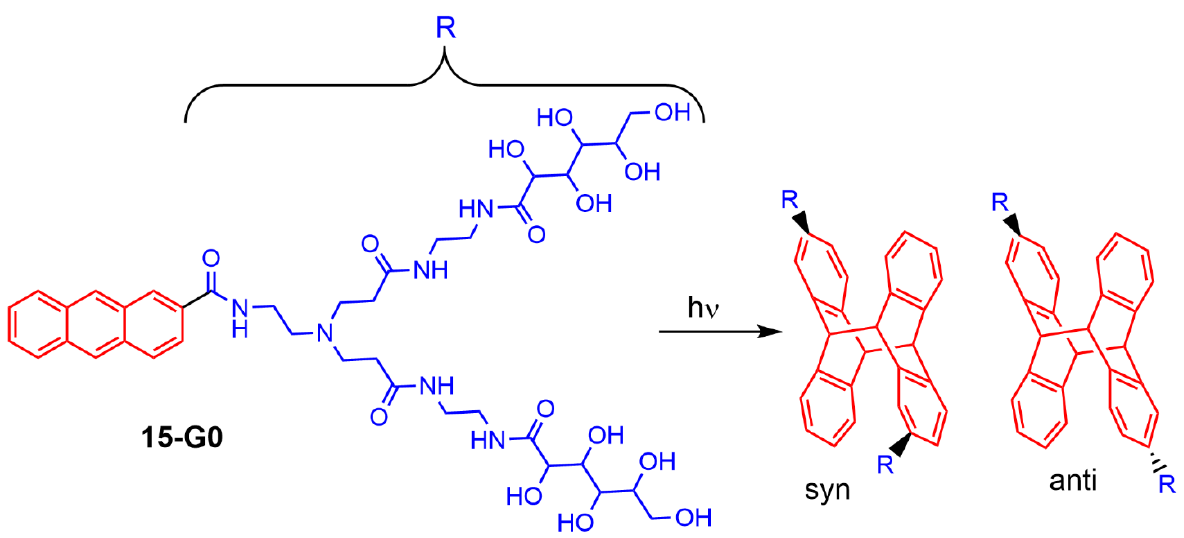
Figure 12. A small dendron having an anthracene at the core, able to dimerize under photo-irradia-